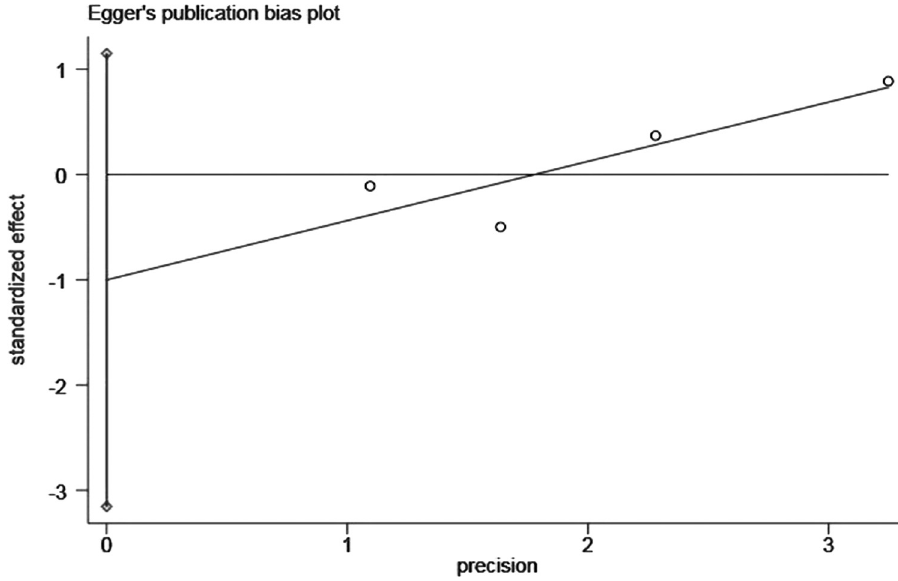
Fig 17. Egger’s publication bias plot of the association between heart disease and bullous pemphigoid mortality.